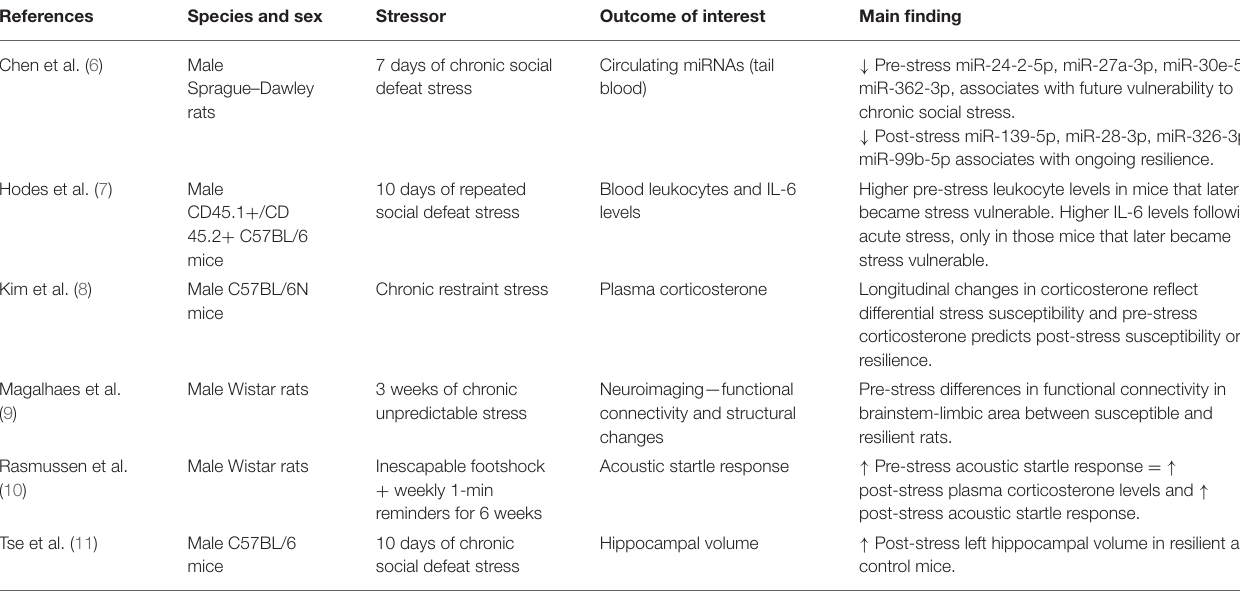
TABLE 1 | Longitudinal animal studies assessing biological outcomes associated with differential susceptibility to